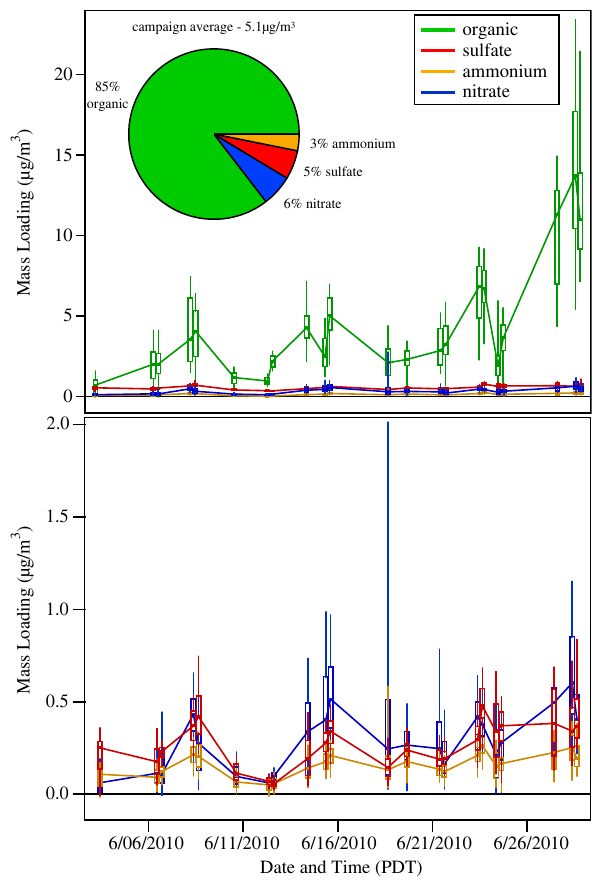
Fig. 1. Box and whisker representations of the AMS-observed non- refractory submicron aerosol organic, sulfate, nitrate, and ammo- nium mass. Each point represents data from one flight of the G-1 research aircraft. Boxes represent the upper and lower quartiles and whiskers represent the 5th and 95th percentiles. The inset in the top panel shows the average particle chemical composition across all flights. Lines connect the median of each point and are shown to guide the